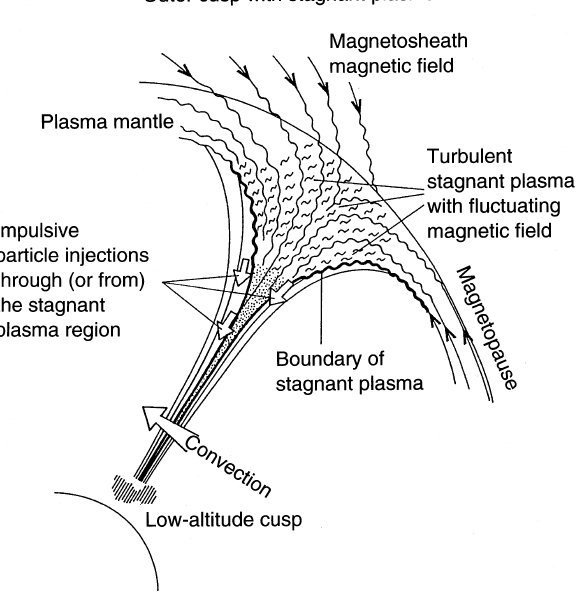
Fig. 6. Sketch of the outer cusp region, including a turbulent stagnant plasma with fluctuating magnetic field (see text for